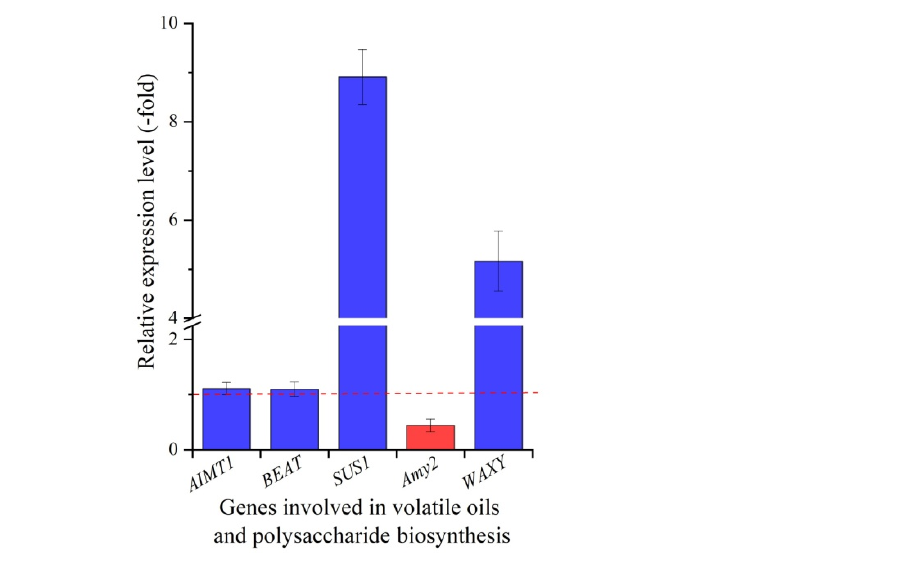
Figure 6. Expression levels of five genes related to volatile oils and polysaccharide biosynthesis in A. sinensis . Abbreviations: AIMT1, trans-anol O-methyltransferase 1; BEAT, acetyl-CoA-benzylalcohol acetyltransfe-rase; SUS1, sucrose synthase isoform 1; Amy2, pancreatic alpha-amylase; WAXY, granule-bound starch synthase 1.